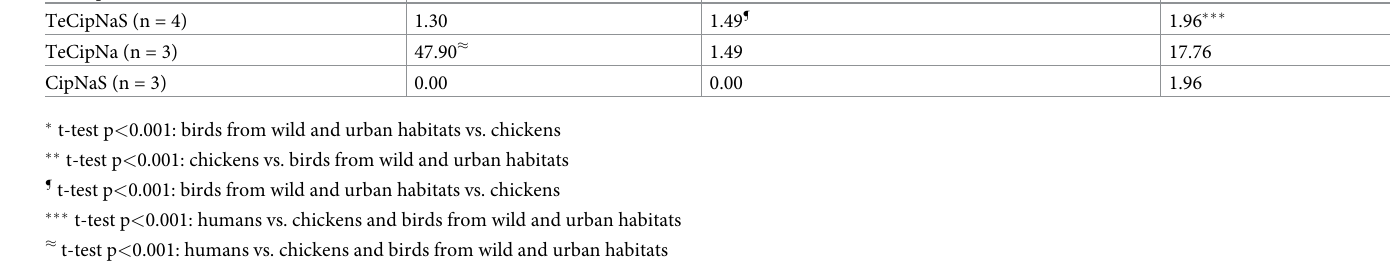
The multidrug resistance (MDR) profiles for C . jejuni are shown in Table 3. We identified six C . jejuni- specific antimicrobial resistance profiles. At 47.90% and 17.76%, the TeCipNa MDR category was the most common for the C . jejuni strains isolated from poultry and humans, respectively. Interestingly, isolates from the birds belonging to the wild and urban environments dominated the EGTeCipNaS and ETeCipNaS MDR categories compared with the other isolate groups (poultry and human isolates) (Table 3).